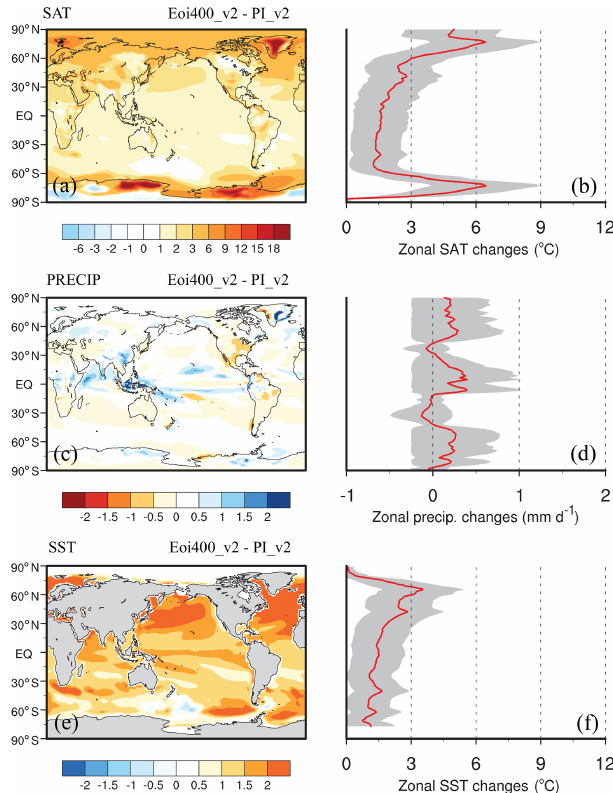
Figure 8. Anomalies of mean annual SAT (a) , mean annual pre- cipitation (c) and mean annual SST (e) of Eoi400_v2 in compari- son with the associated PI control experiment. Panels (b) , (d) , and (f) represent the zonal mean of related anomalies; the shaded area shows 1 σ standard